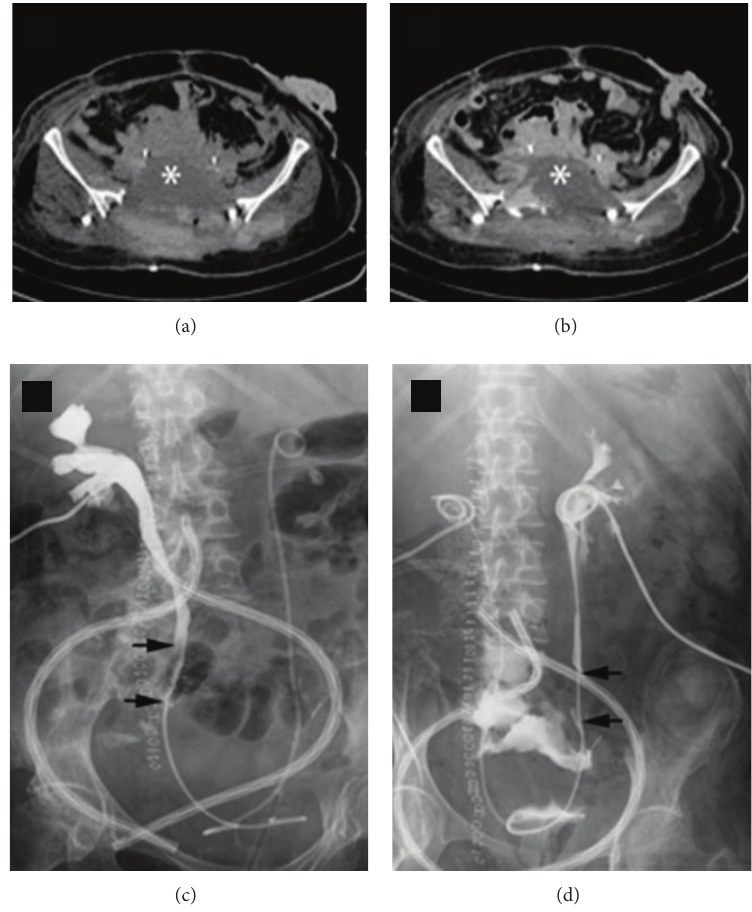
Figure 2: Noncontrast-enhanced (a) and contrast-enhanced (b) CT scans of the pelvis after radical sacrectomy. A large fluid collection (white star) surrounds the ureters where two double-J stents were positioned. Pyelography through the bilateral nephrostomies showing the transection of both ureters (black arrows) and contrast media leakage ((c) and